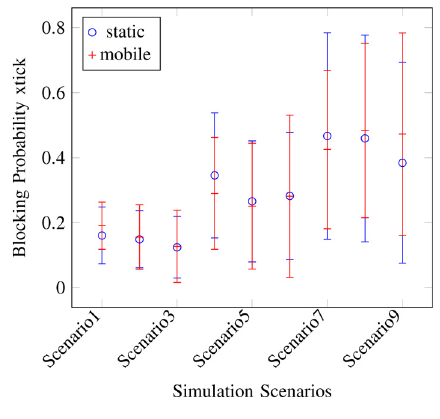
Figure A2. Average blocking probability for DiSim